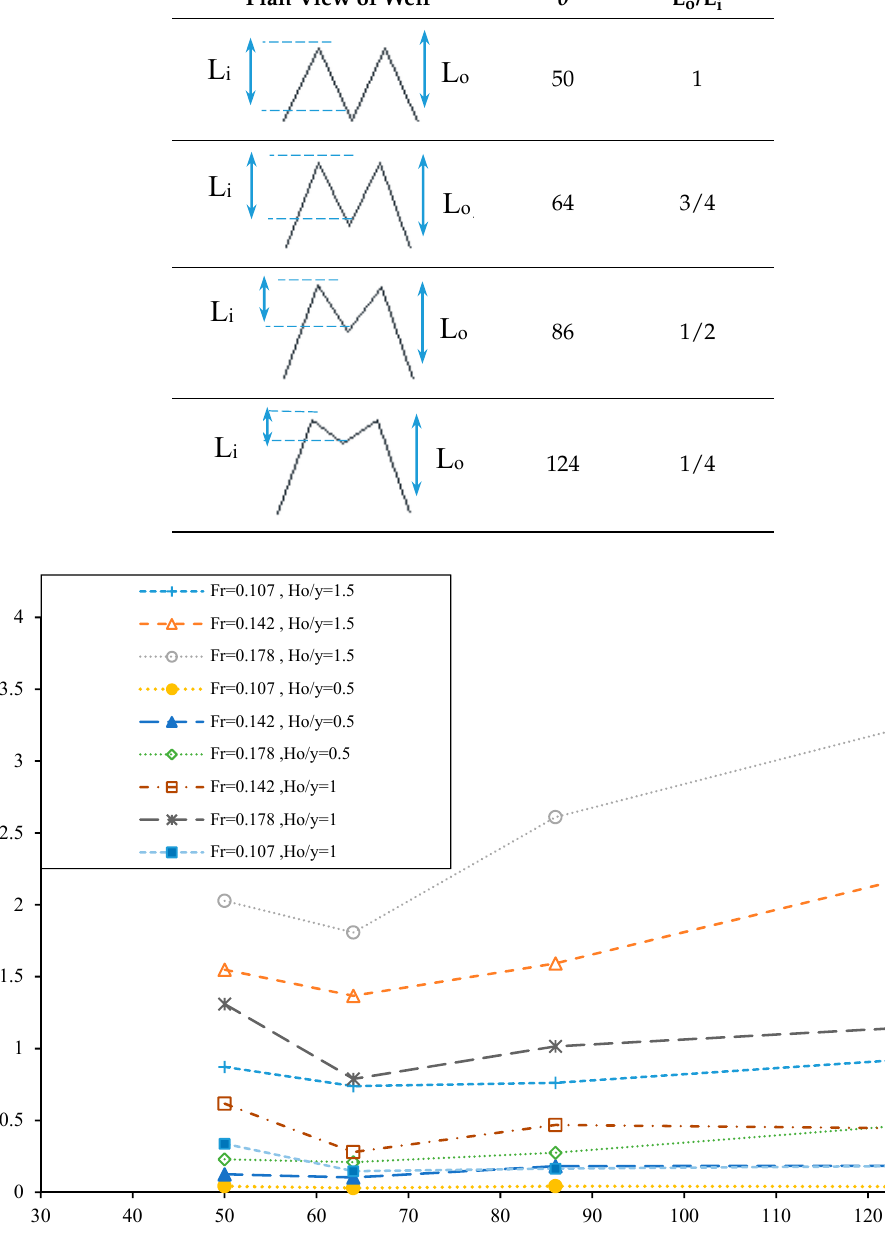
Figure 3. The effect of inner angle of W-weir on the size of scour.